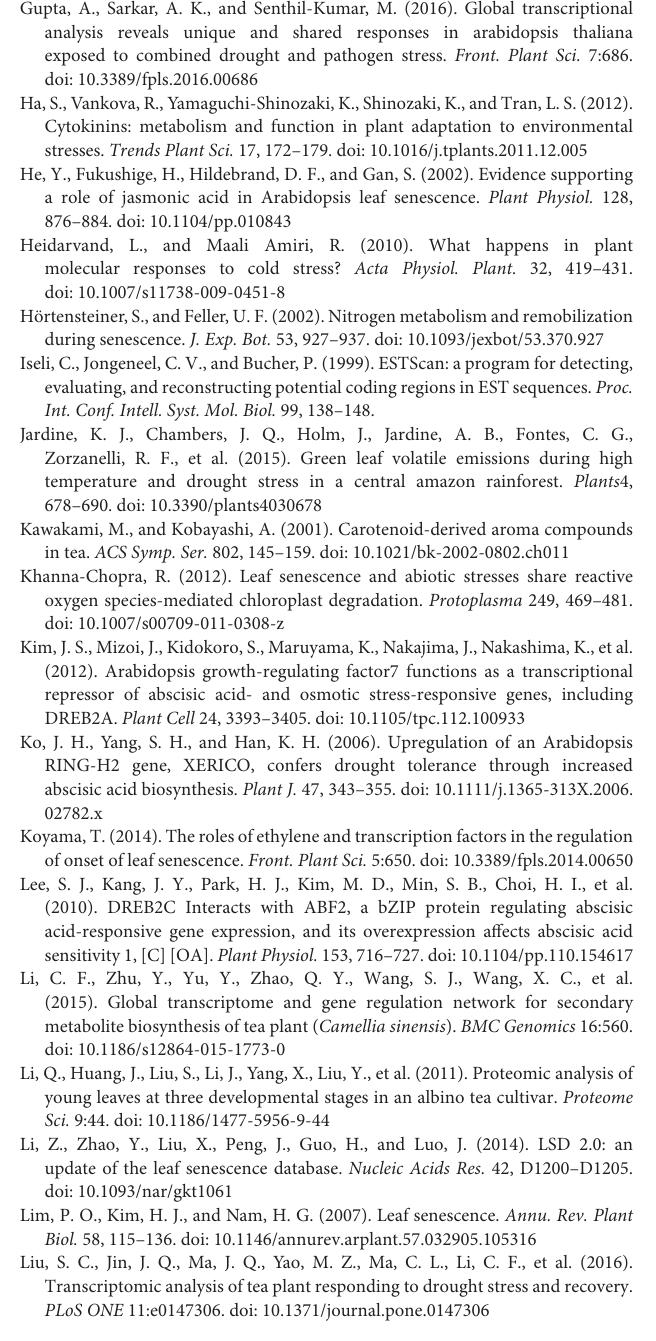
Supplementary Table 4 | List of unigenes among the 20 transcriptional response modes. Supplementary Table 5 | List of selected differentially expressed SAGs with known effect. Supplementary Table 6 | List of CD-unique DEGs. Supplementary Table 7 | KEGG pathway classification of CD-unique DEGs. Supplementary Table 8 | List of DEGs involved in ROS production, starch and sucrose metabolism.